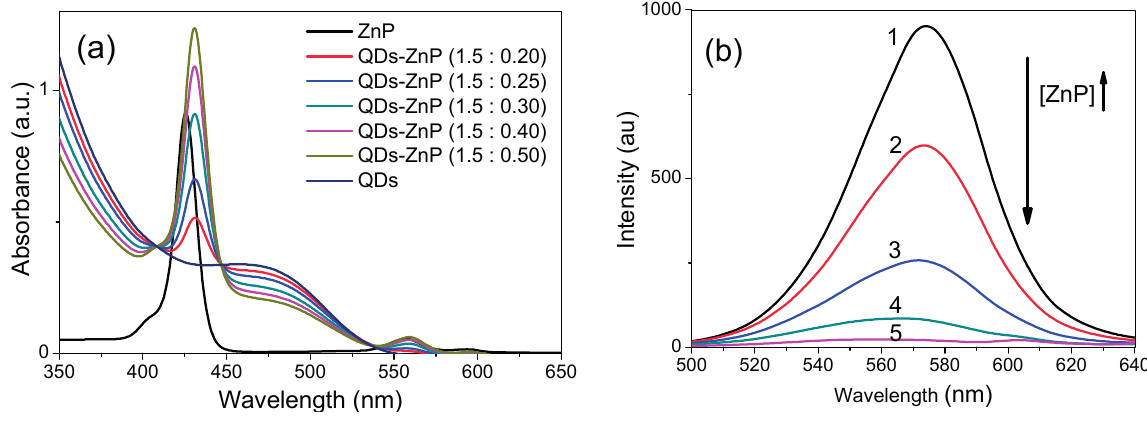
Figure 4. ( a ) Absorption spectra of different molar ratios of QDs:ZnP; ( b ) Emission spectra of CdTe-MSA QDs ( λ exc = 460 nm) with addition of increasing quantities of ZnP (1) = QDs; (2) QDs:ZnP 1:0.12; (3) QDs:ZnP = 1:0.25; (4) QDs:ZnP = 1:0.5; (5) QDs:ZnP =